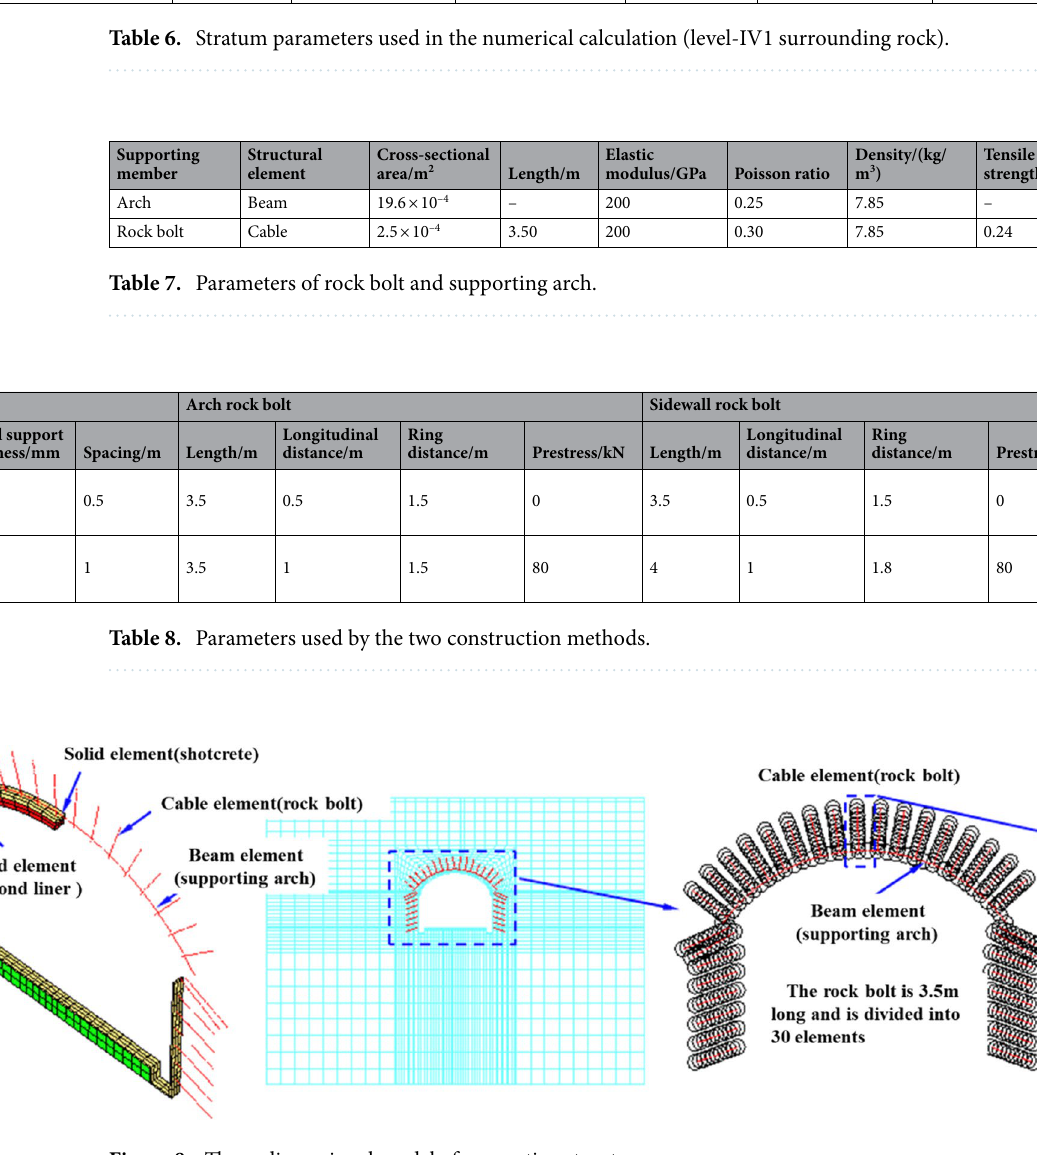
Figure 8. Three-dimensional model of supporting